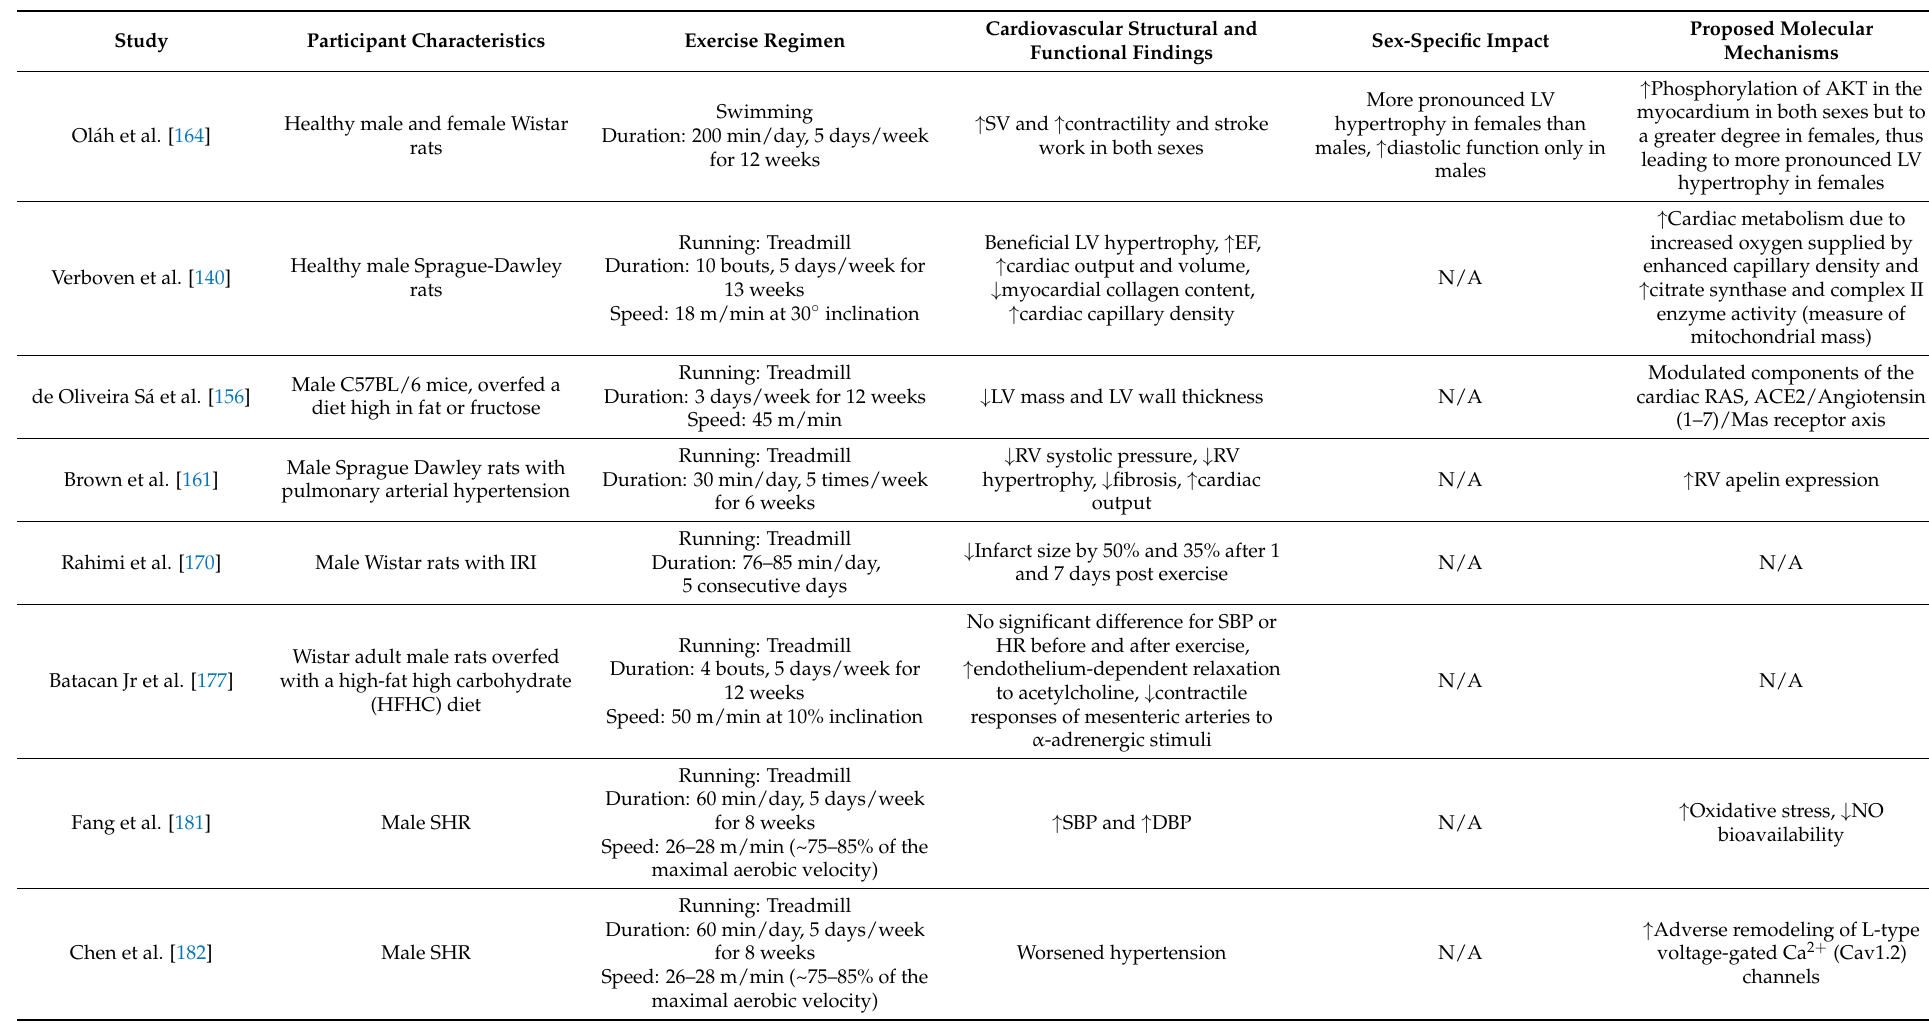
Table 4. The described studies associated with the high-intensity training (HIT)